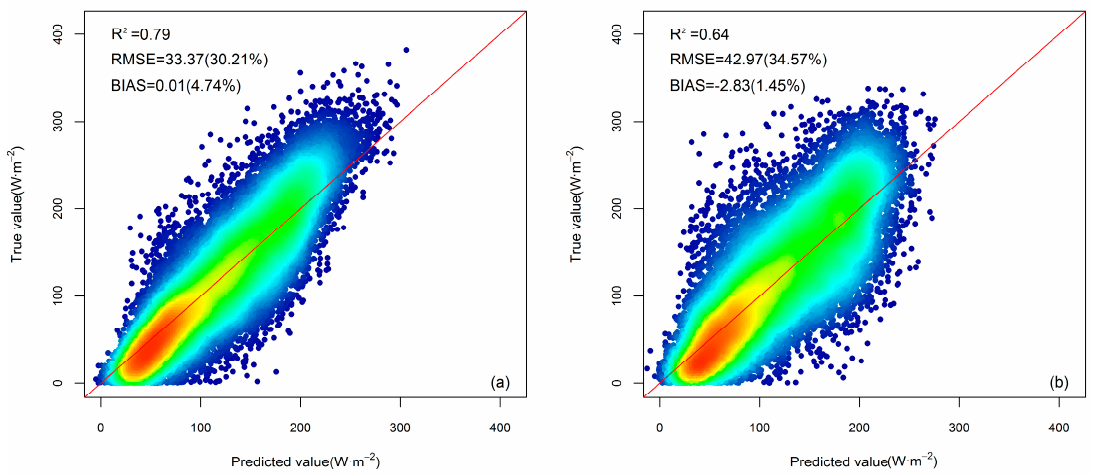
Figure 6. ( a ) Evaluation results of the training set’s daily estimated DSR based on the GBRT-based cloudy sky model against ground measurements in 2001 and 2002. ( b ) Evaluation results of the validation set’s daily estimated DSR based on the GBRT-based cloudy sky model against ground measurements in 2003. The number in the parentheses is the percent bias or RMSE value.